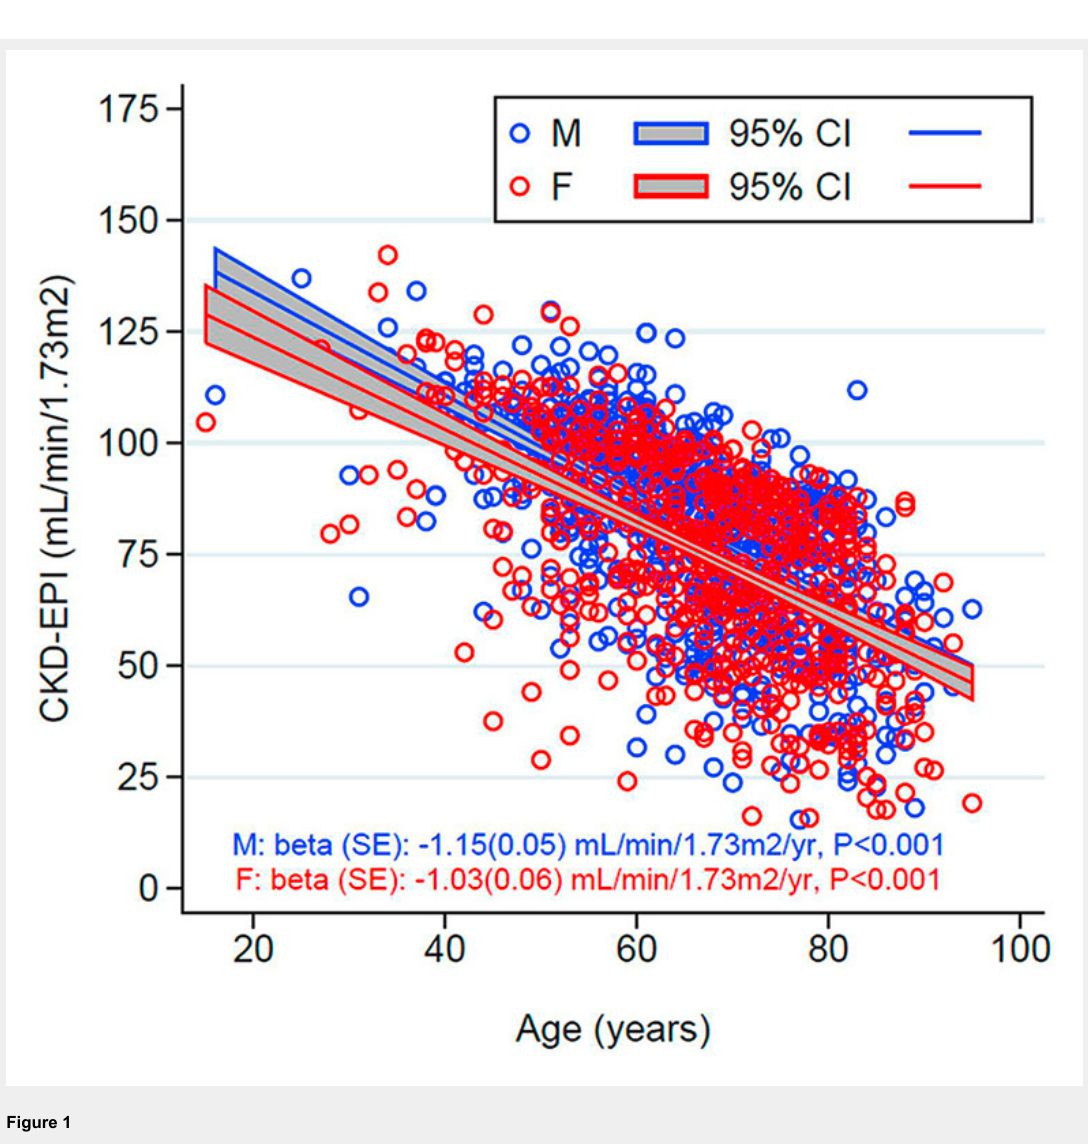
Figure 1 Beta coefficient and standard error (SE) from simple linear regression. CI = confidence interval; CKD-EPI = chronic kidney disease-epidemiology